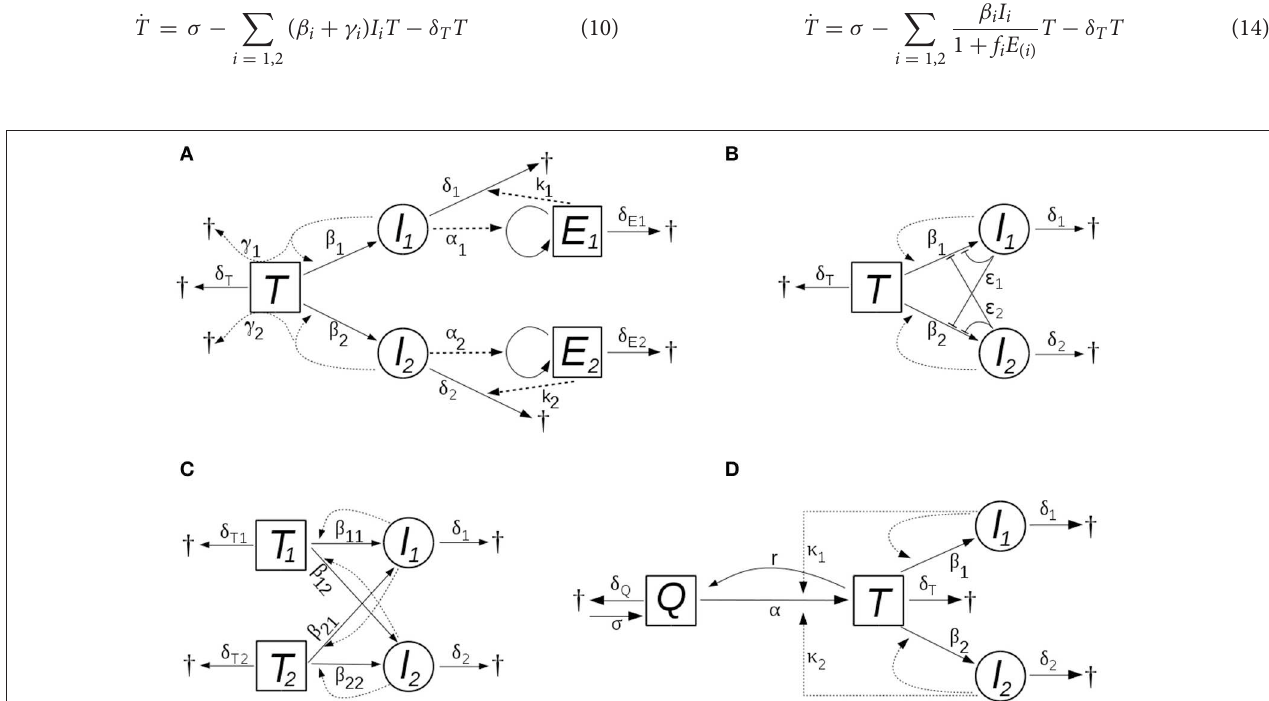
FIGURE 1 | The schemes of the models with (A) bystander killing and (optional) strain-specific cytotoxic immunity, (B) saturating dynamics of new infections, (C) multiple target cell types, and (D) HIV induced activation of target cells. New infections occur proportional to the level of infected cells in all models; the level of infectious virions is assumed to follow that of the infected cells, with a proportionality constant implicit in the infection parameter ( β ). The processes and parameters are explained in the text.